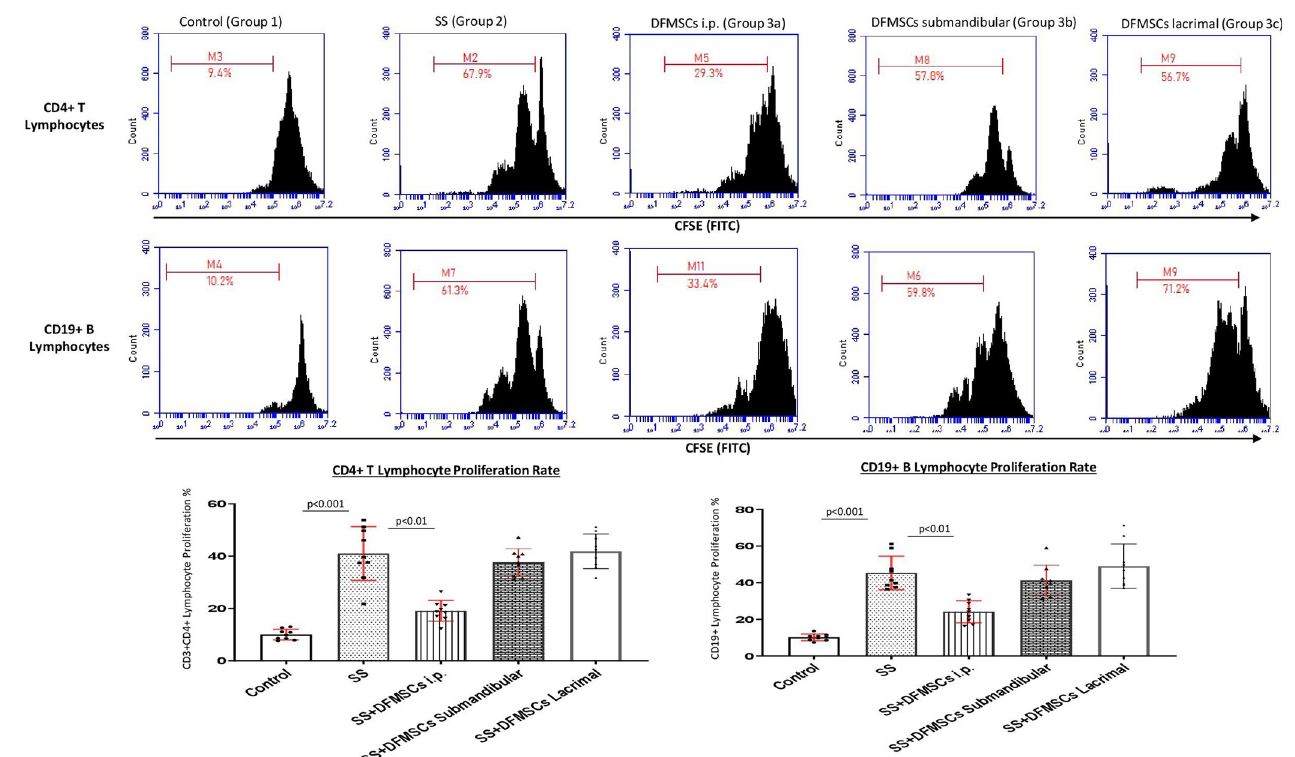
Fig 1. Lymphocyte proliferation analysis in the splenocytes. CD3+CD4+ T lymphocyte proliferation rate was significantly high in SS mice (Group 2) compared to the control group (Group 1) (p < 0.001). The intraperitoneally injected DFMSCs (Group 3a) significantly decreased CD3+CD4+ T lymphocyte proliferation rate compared to Group 2 (p < 0.01). Submandibular and lacrimal injections of DFMSCs tended to decrease the lymphoproliferative responses of CD3+CD4+ T lymphocytes compared to Group 2, but no significant difference was observed (p > 0.05). CD19+ B lymphocyte proliferation rate was significantly high in SS mice (Group 2) compared to the control group (Group 1) (p < 0.001). The intraperitoneal injection of DFMSCs (Group 3a) significantly decreased CD19+ B lymphocyte proliferation rate compared to Group 2 (p < 0.01). Submandibular and lacrimal injections of DFMSCs did not significantly change the lymphoproliferative responses of CD19+ B lymphocytes compared to Group 2 (p > 0.05).